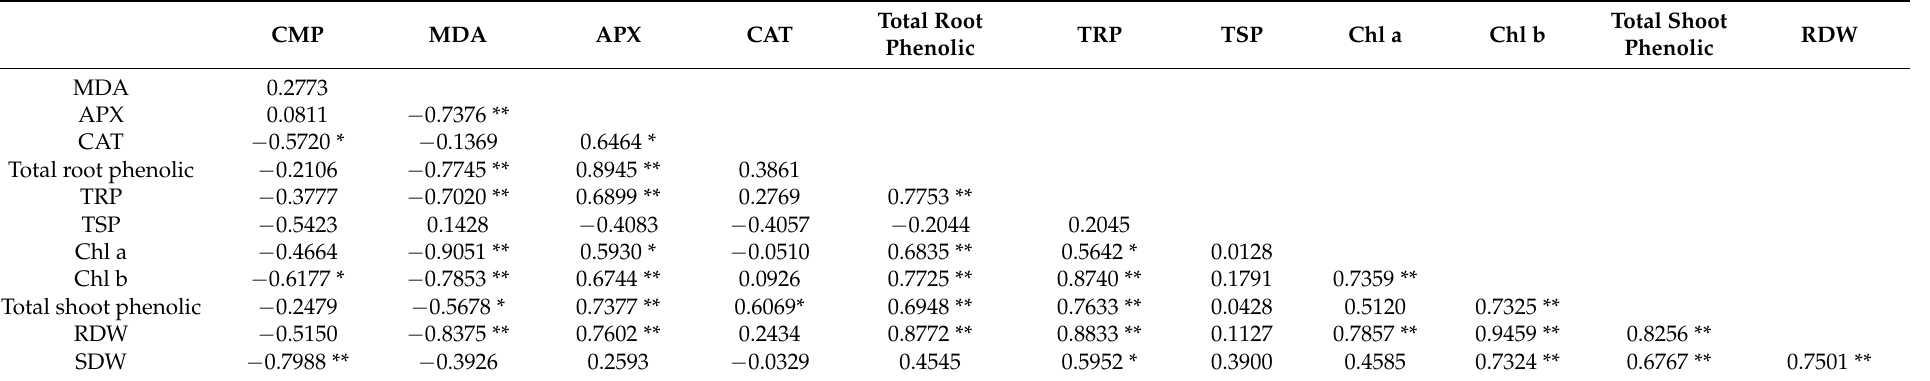
Table 4. Pearson coefficient correlation drawn between the radish dry weight and its physiological and biochemical